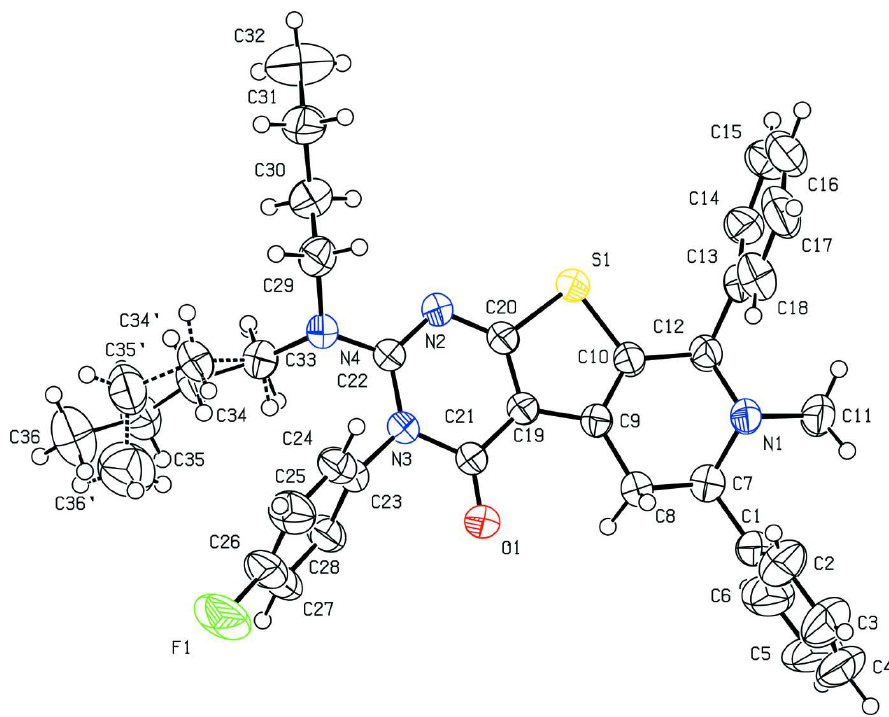
Molecular structure of the title compound with labelling and displacement ellipsoids drawn at the 50% probability level 2-(Dibutylamino)-3-(4-fluorophenyl)-5,6,7,8-tetrahydro-7-methyl-6,8- diphenylpyridine[3 ′ ,4 ′